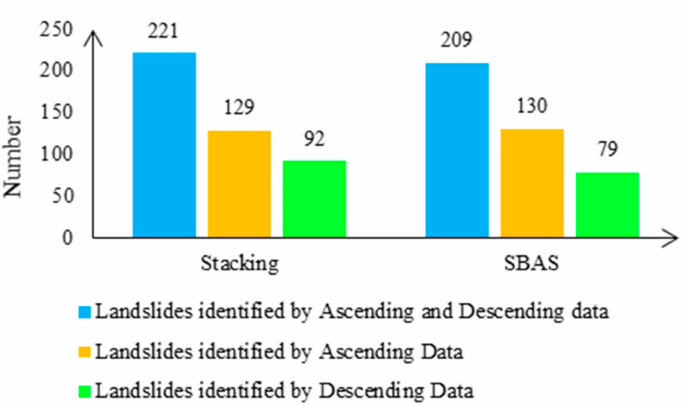
Figure 10. Statistics of the number of landslides identified by ascending and descending orbit data in the study area.